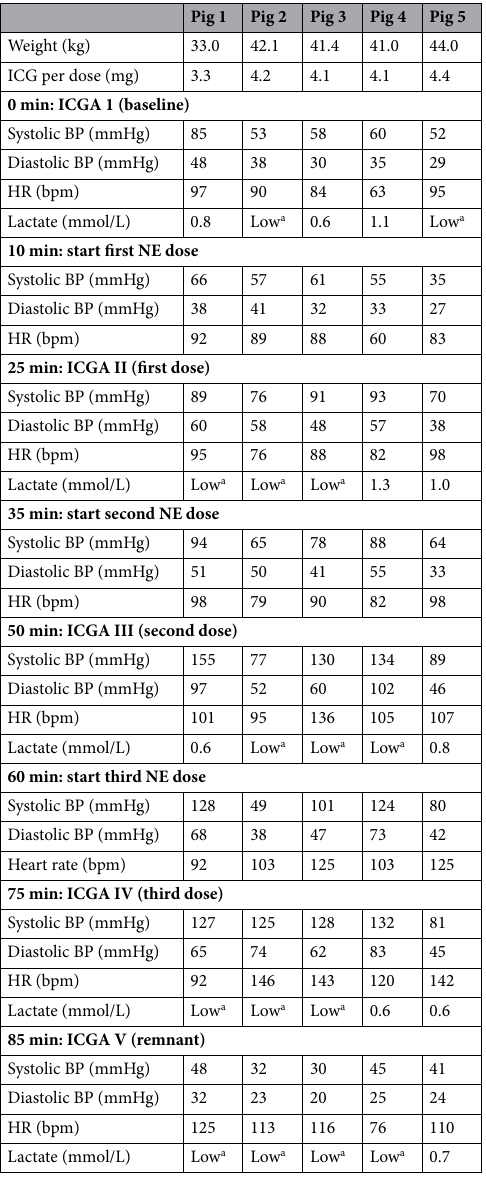
Table 1. Measurements (BP, HR, and lactate levels) per pig over time. ICGA indocyanine green angiography, BP blood pressure, HR heart rate, bpm beats per minute, NE norepinephrine. a Lactate levels between 0.1 and 0.6 mmol/L.